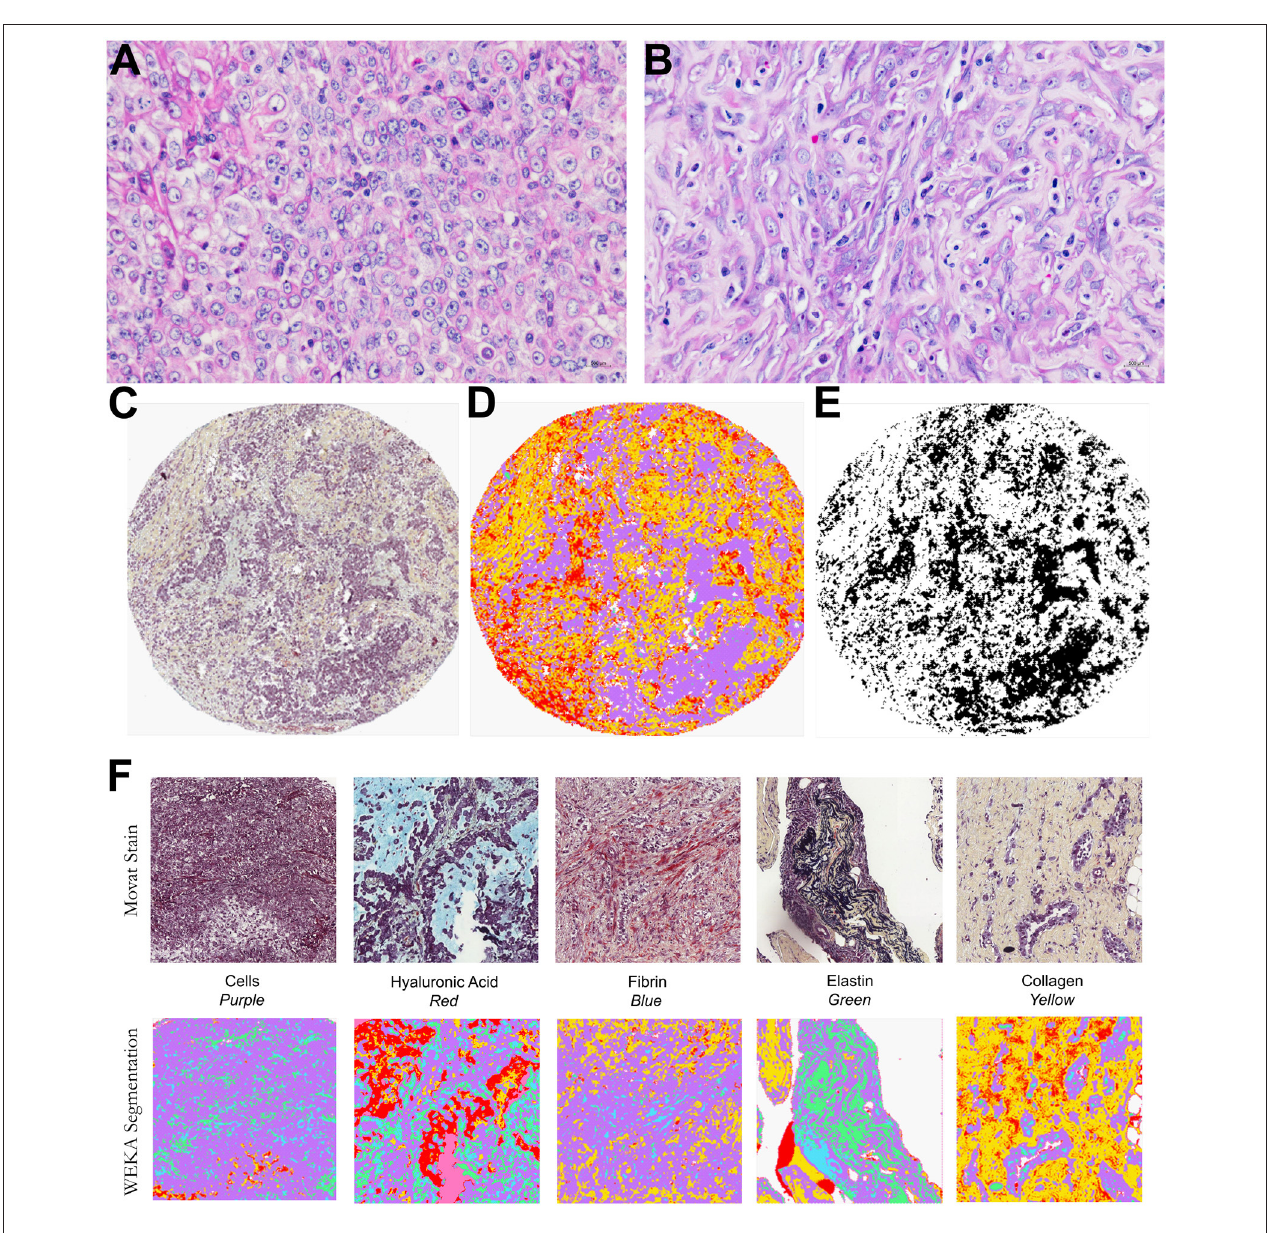
FIGURE 1 | Histological characterization of a malignant mesothelioma (MM) cohort. Epithelioid (A) and sarcomatoid (B) MM stained by HE. Input images (C) , TMA spot stained by modified Russell-Movat staining; (D,E) output of the Weka segmentation and of the threshold segmentation for data extraction by coloration. (F) Input and output images of the Weka segmentation, showing areas of segmented fundamental